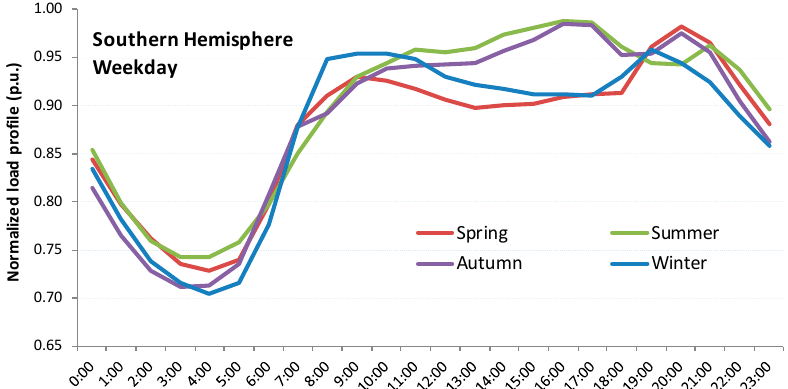
Figure 10. Standard normalised demand profiles for weekend days in the Southern Hemisphere. Source: [83,84] and self-elaboration.